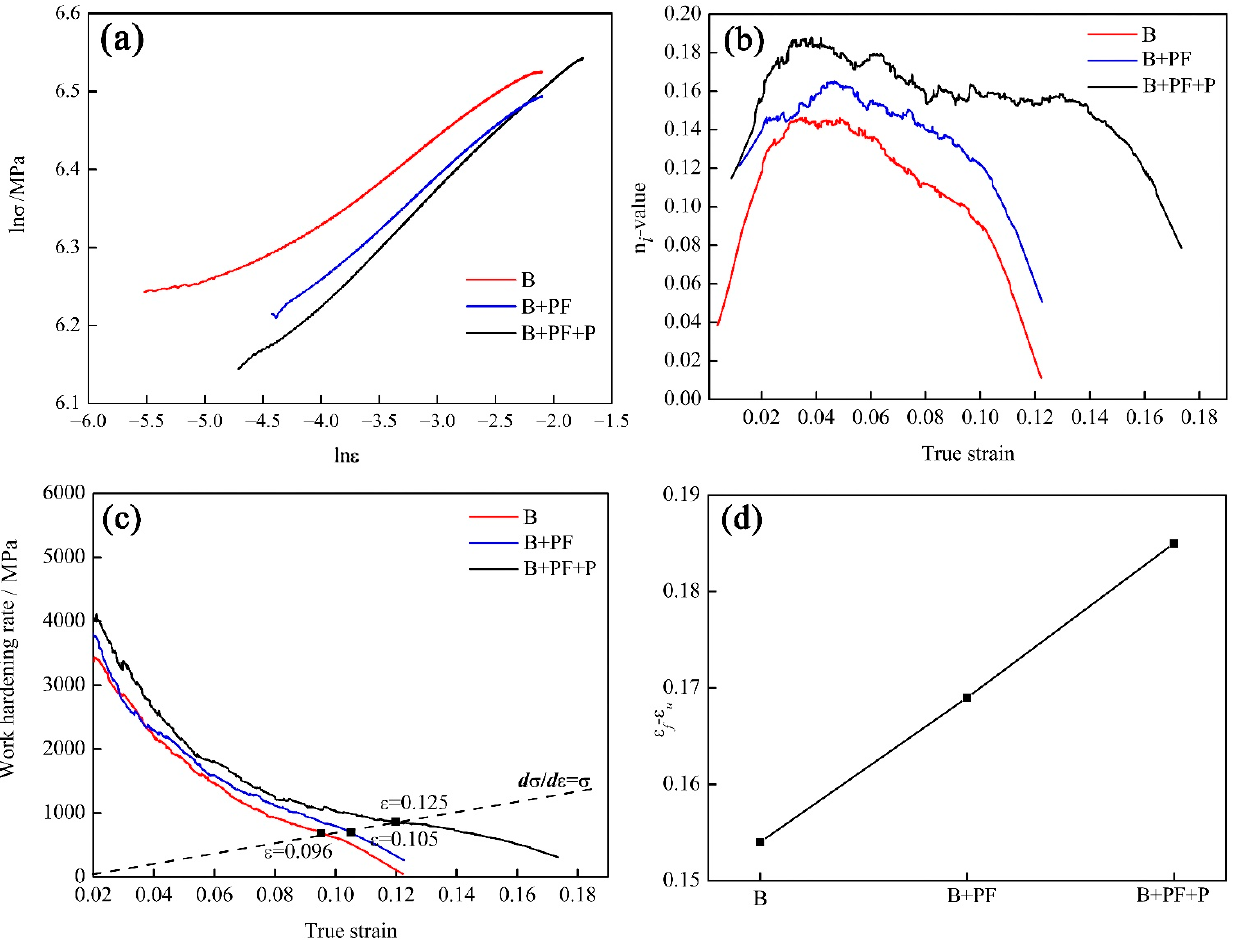
Figure 6. ( a ) ln σ − ln ε curves, ( b ) n i values, ( c ) work-hardening rate ( d ) extended strain after Table 3. The work hardening exponent of three samples.